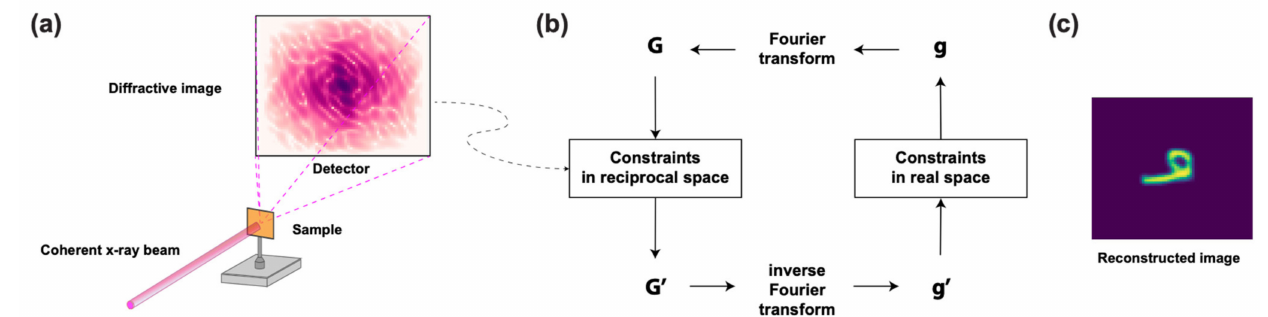
Figure 1. ( a ) A schematic of experimental setup for coherent X-ray imaging. Coherent X-ray beam illuminates a sample in a transmission geometry and a diffracted image is recorded on a detector in a far field. ( b ) A conceptual architecture of the Gerchberg–Saxton algorithm. A diffracted image obtained in experiment is used for a constraint in reciprocal space. ( c ) A reconstructed amplitude of an object results from the Gerchberg–Saxton